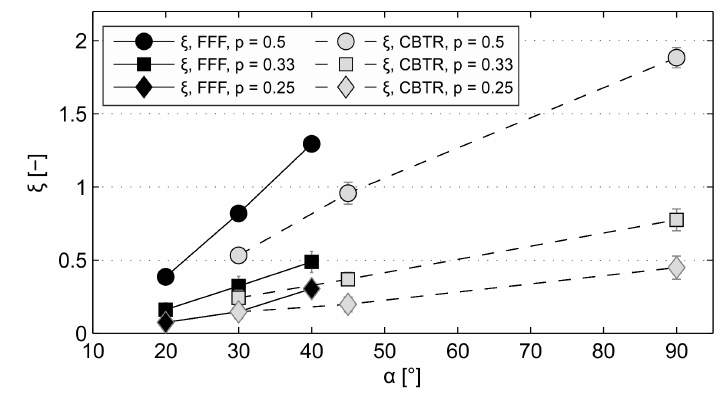
Figure 9. Head loss coefficient ξ versus rack angle α for both rack options (CBTR and